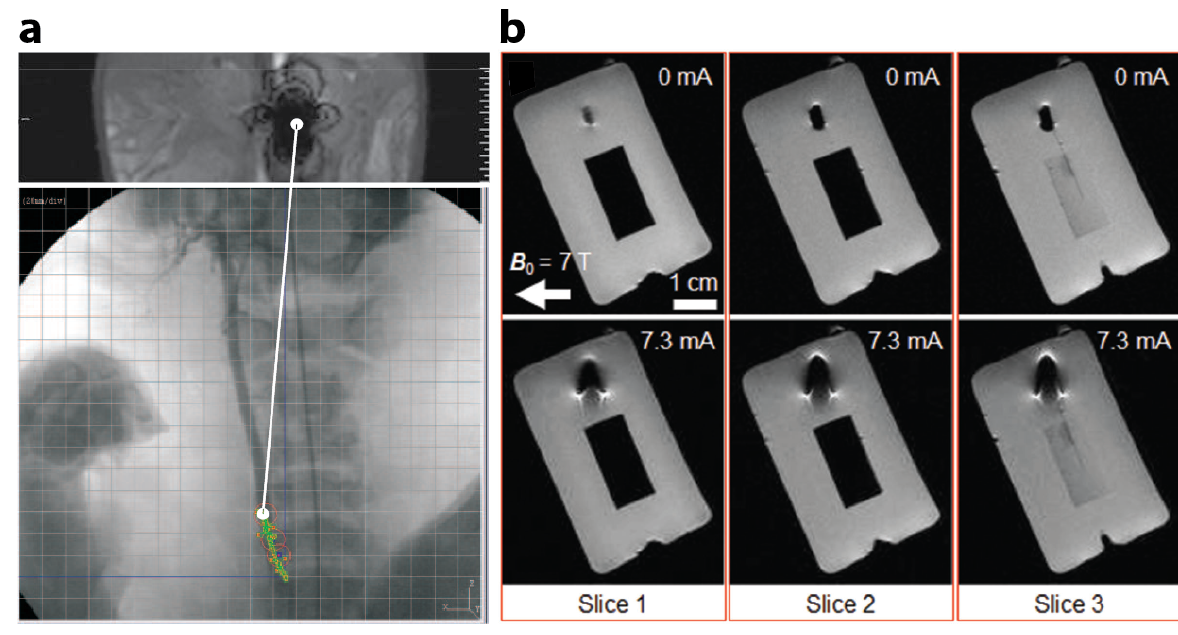
Figure 3. Exemplar studies of small-scale magnetic robots with integrated MRI modality. ( a ) Distorted MRI image created by a 1.5 mm-diameter chrome steel sphere, which was tracked over a pre-acquired X-ray image while being controlled at 24 Hz in the carotid artery of a living swine along the waypoints. Reproduced from [73] under STM Permissions Guidelines. ( b ) Three different MR image slices of the nonoperated (off, 0 mA) actuator showing no image artifact and operated actuator showing beam bending and generated image artifacts inside a preclinical MRI scanner. Reproduced with permission